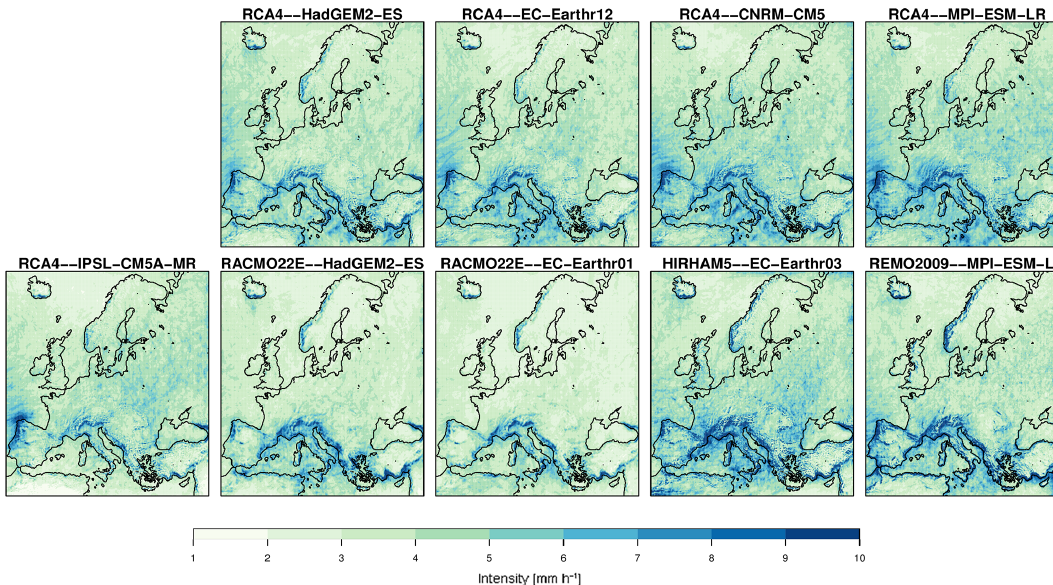
Figure 7. Intensity for 10-year return period for a 12h duration of all models in the RCM ensemble.